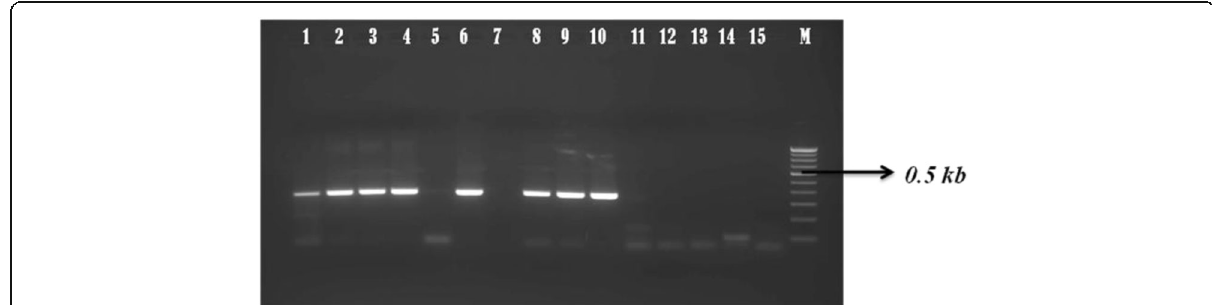
Fig. 5 The 1.5% ethidium bromide-stained agarose gel showing PCR amplification from the selected native B. thuringiensis stains using cry1Ab gene primer combinations. Legends : M — Molecular Weight Marker (100 bp, Thermo Scientific, USA), Lane1 — BNG_Bta1, Lane2 — SHVM_Bta2, Lane3 — MYS_Bta3, Lane4 — VJP_Bta4, Lane5 — no Amplification, Lane6 — CMR_Bta6, Lane7 — no amplification, Lane8 — BID_Bta8, Lane 9 — AN_Bta1,